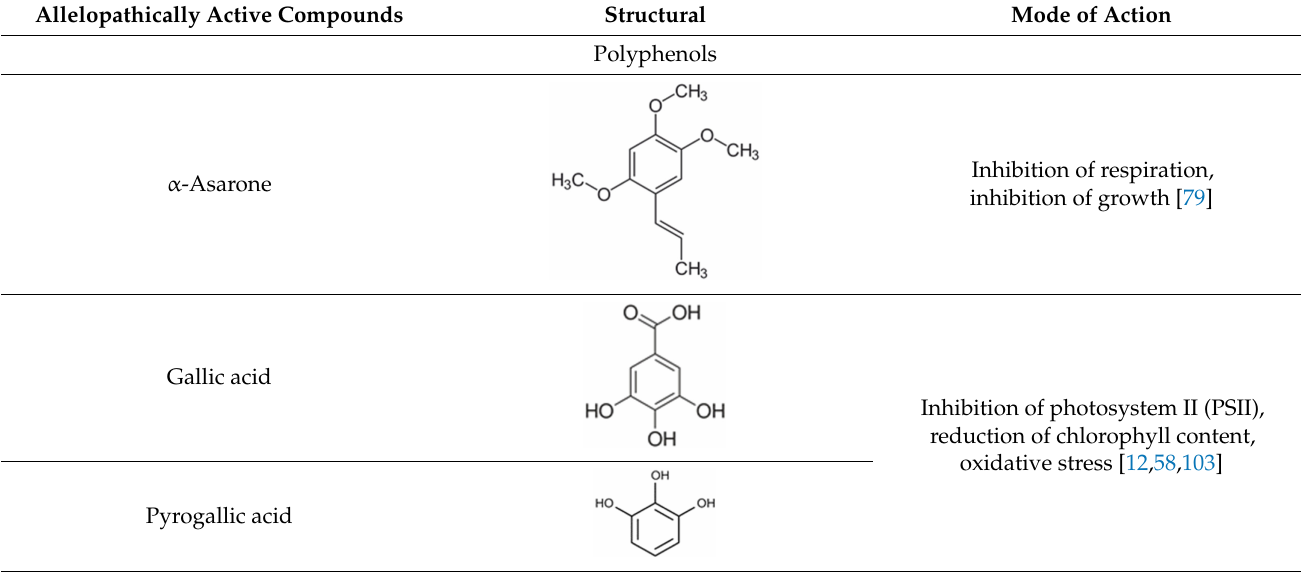
Table 2. The mechanism of inhibitory action of some allelopathically active substances of aquatic vascular plants on